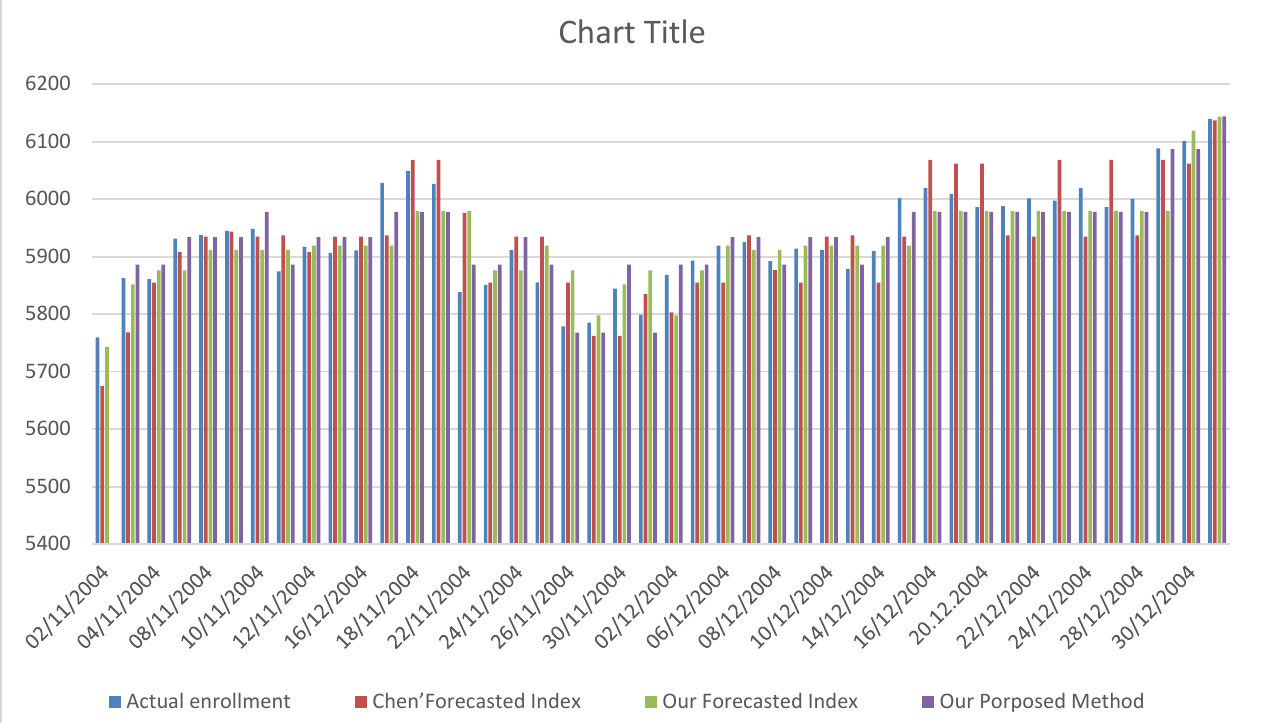
Figure 4. Chart illustrates Table